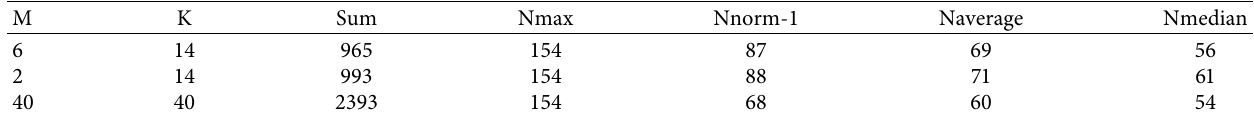
Table 4: Normalization comparison (unit: